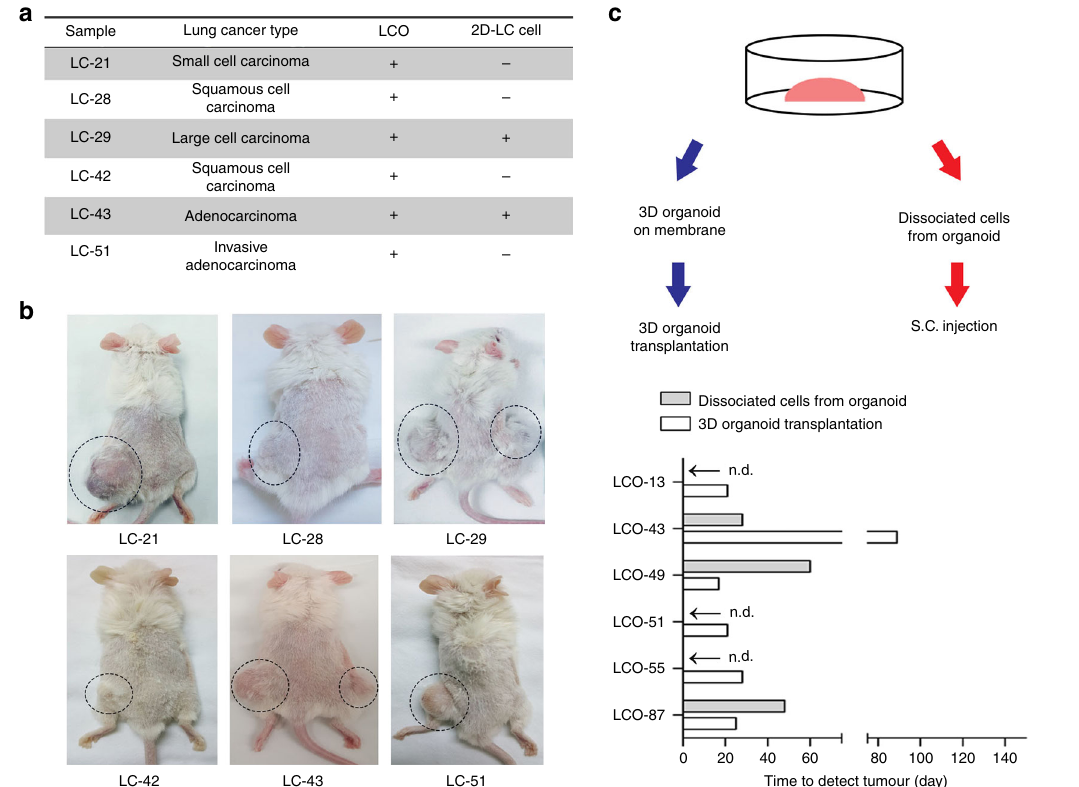
Fig. 5 PDXs from LCOs maintain the characteristics of the original tissues. a List of PDXs established by transplanting LCOs or injecting 2D-LC cells. Transplanted LCOs and injected 2D-LC cells that formed tumours in mice are marked as “ + ” , and the LCOs and 2D-LC cells that did not form tumours are marked as “ − ” . b Images of mice used to establish PDXs. LCOs (left) and 2D-LC cells (right) were simultaneously transplanted or injected into the same mouse. Circles indicate the formed tumours. c Experimental design and results. Bar graph showing the number of days until tumour formation. n.d: tumour not detected